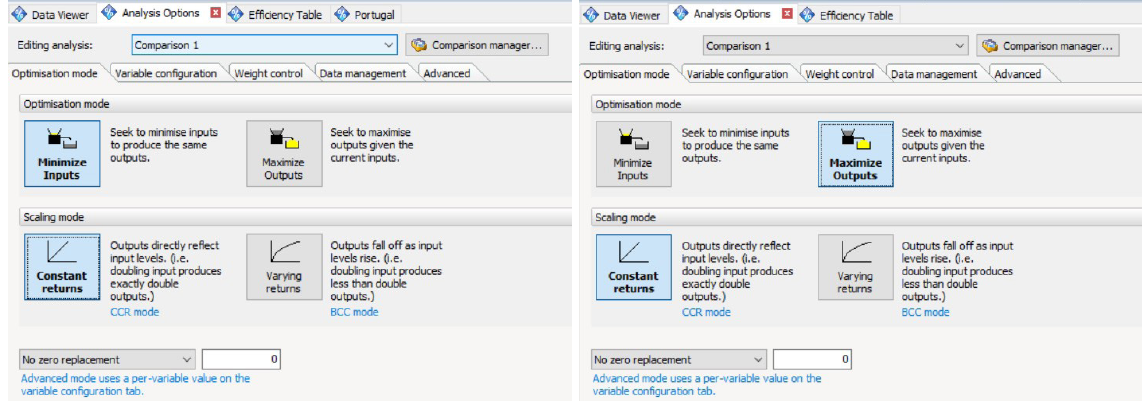
Figure 3. Window for selecting for building an input-oriented BCC model and the output-oriented CCR model